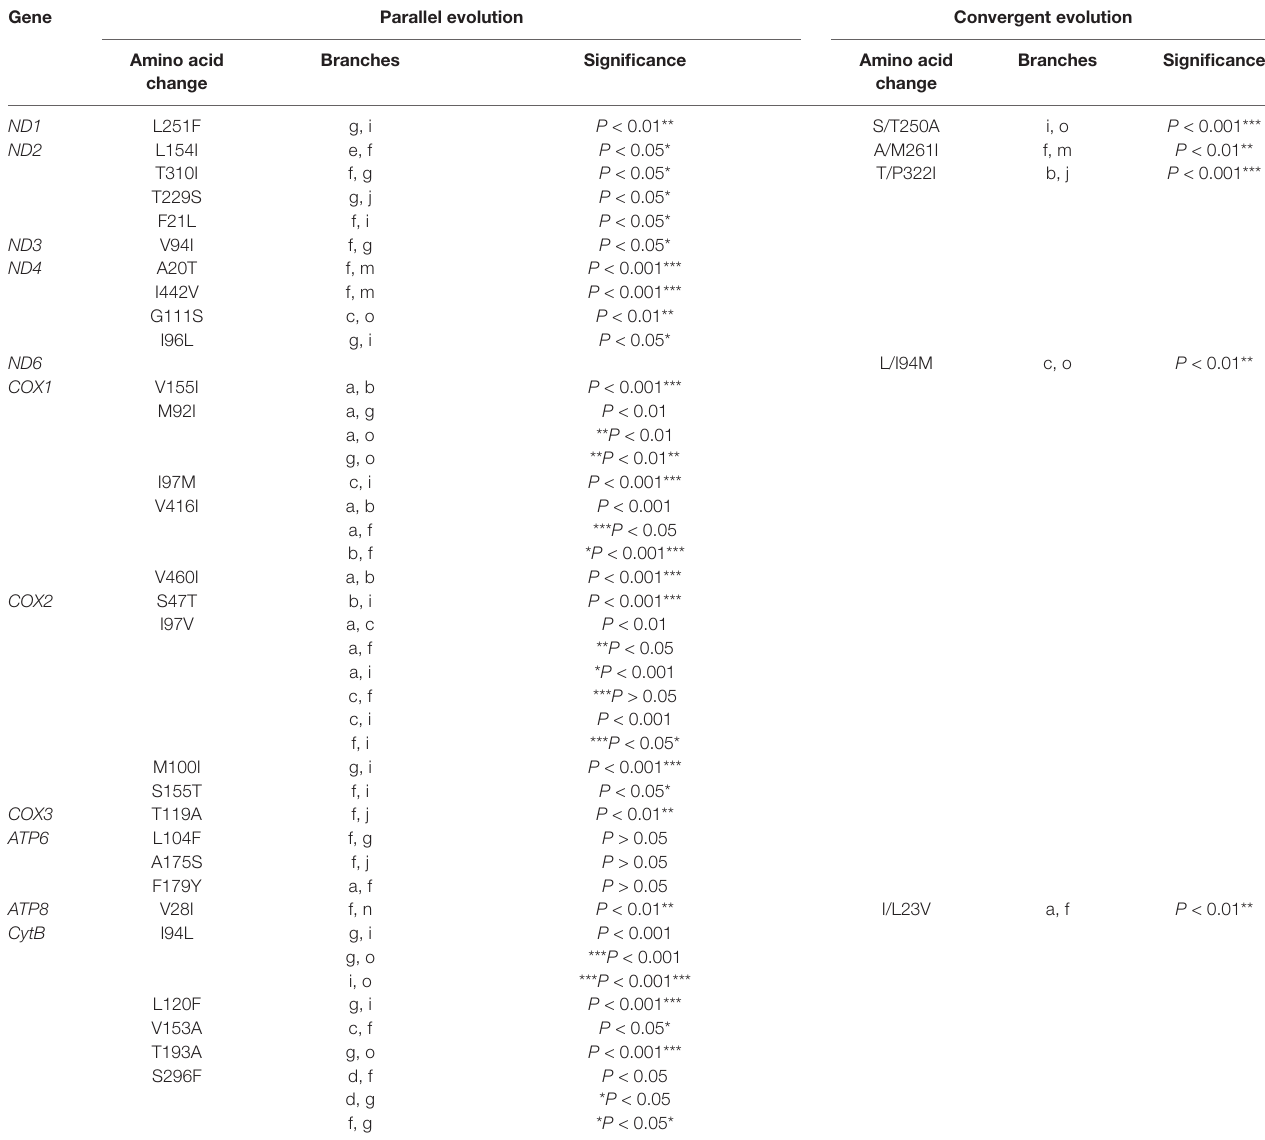
TABlE 2 | Convergent/parallel sites in 11 of 13 mitochondrial protein-coding genes in deep-sea fishes. Gene Parallel evolution Convergent evolution Branches Significance Amino acid Branches change